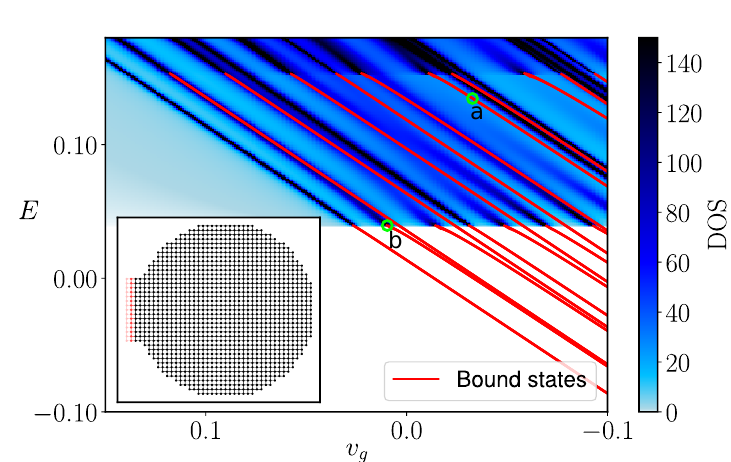
Figure 4: Color plot: density of states in the scattering region, from zero (white) to 150 (dark blue) as a function of v . Red lines: energies of bound states calculated using our algorithm. g Inset: the scattering region (black) and a few cells of the lead (red). This system consists of about one thousand sites. The wavefunctions corresponding to the two circles (a) and (b) are shown in Figures 5a) and